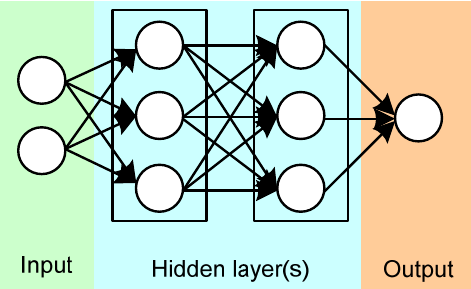
Figure 7. Typical structure of ANNs.